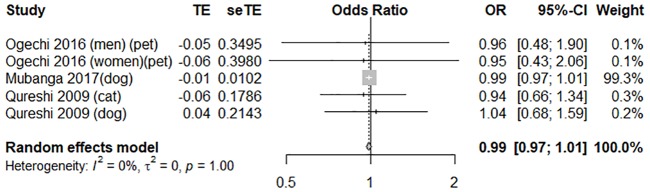
A forest plot of the risk of myocardial infarction between pet owners and non-pet owners.CI, confidence interval; OR, odds ratio; SE, standard error; TE, treatment effect.